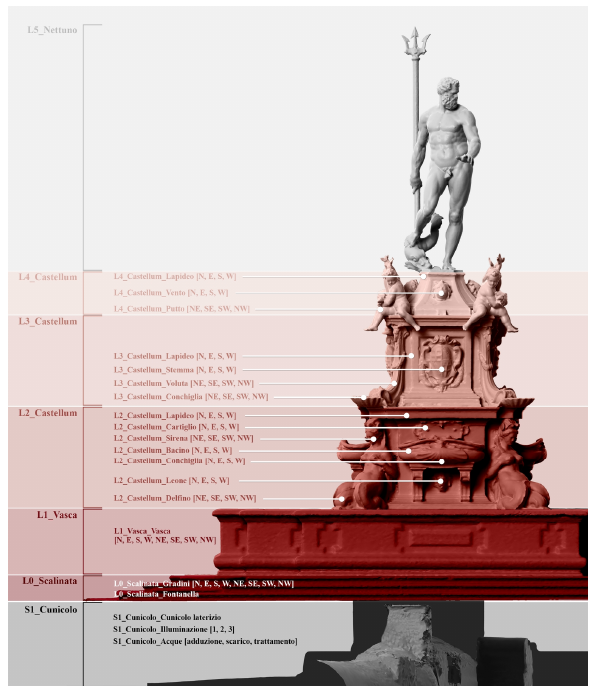
Figure 2. Semantic partition of the 3D digital model of the Neptune’s Fountain and its levels and sub-elements